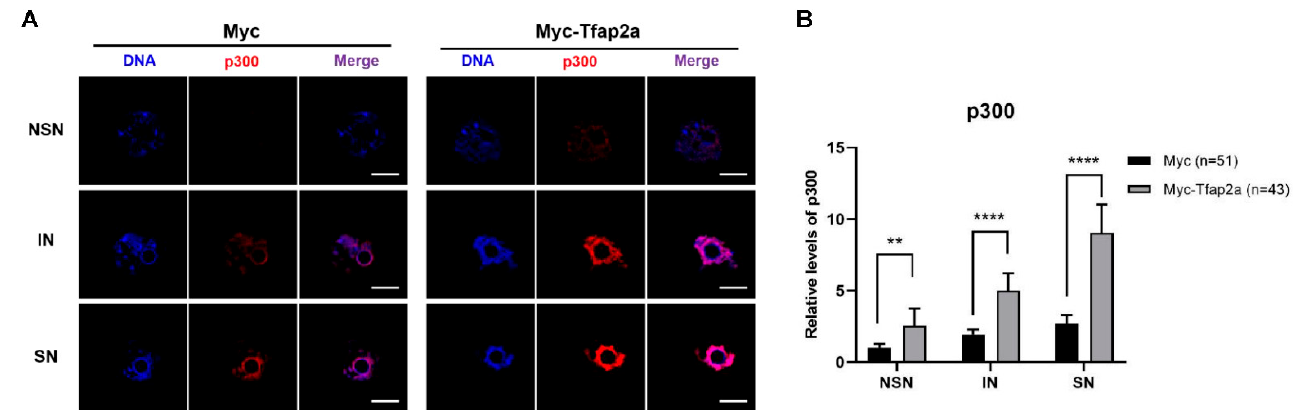
Figure 6. Subcellular localizations and levels of p300 after the overexpression of Tfap2a. ( A ) GV- stage oocytes were microinjected with Myc or Myc-Tfap2a mRNA, respectively, and incubated with 200 nM IBMX for 12 h. p300 is shown in red, and DNA is indicated in blue. Scale bar = 20 µm. ( B ) Quantification data of images in ( A ). The average relative fluorescence intensity of the NSN oocytes from the Myc group was set to 1. Data are expressed as the mean ± SEM of at least three independent experiments. ** p < 0.01, **** p < 0.0001.